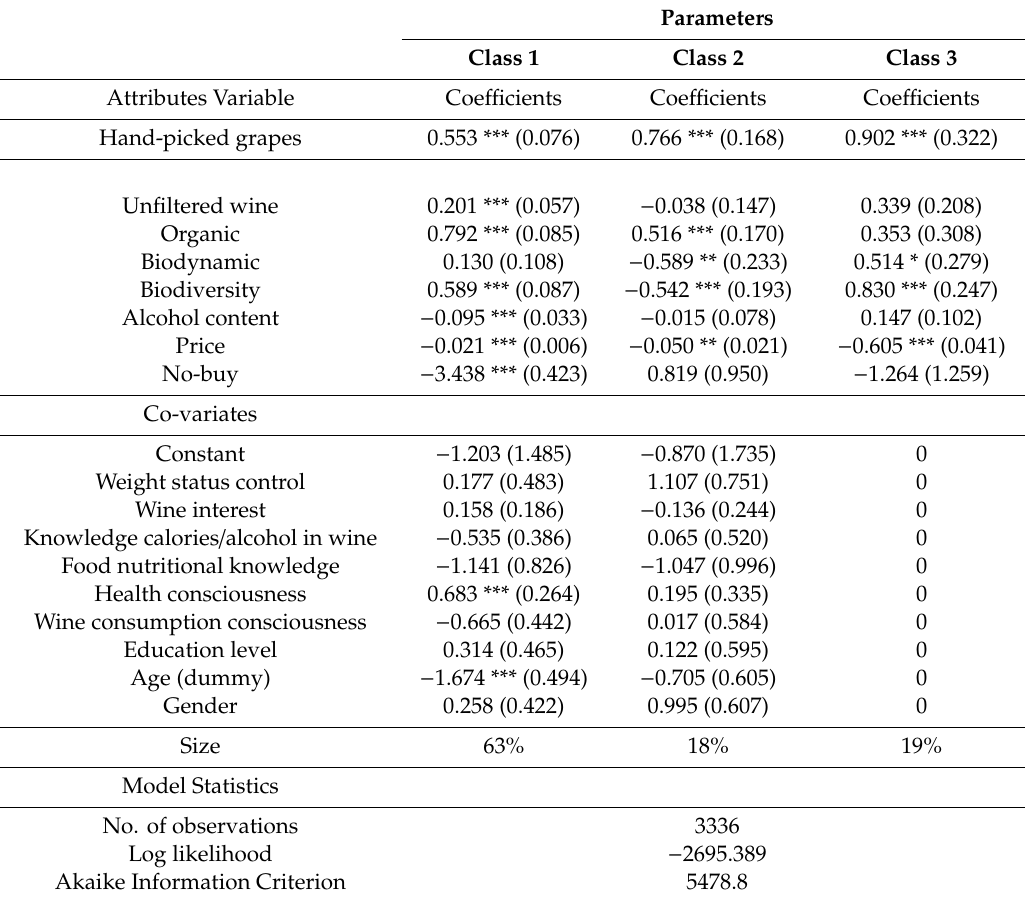
Table 5. Latent class model